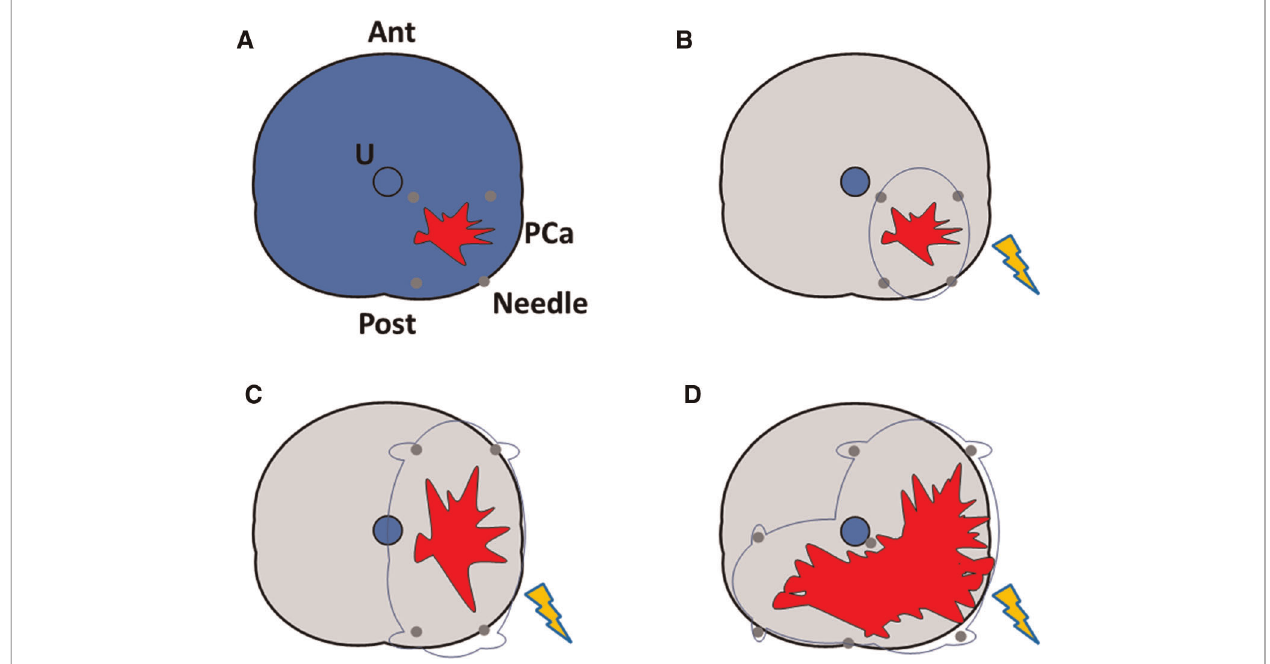
FIGURE 2 | Different axial representations of salvage irreversible electroporation ablation schemes used in the SAFE study. Ant, anterior prostate; U, urethra; PCa, prostate cancer focus (red); Needle, irreversible electroporation needle (gray); ablation zone is displayed in orange. ( A ) Overall prostate view; ( B ) focal ablation; ( C ) hemi-ablation; ( D ) hockey stick ablation. Quadrant ablation will also be performed (not shown in the